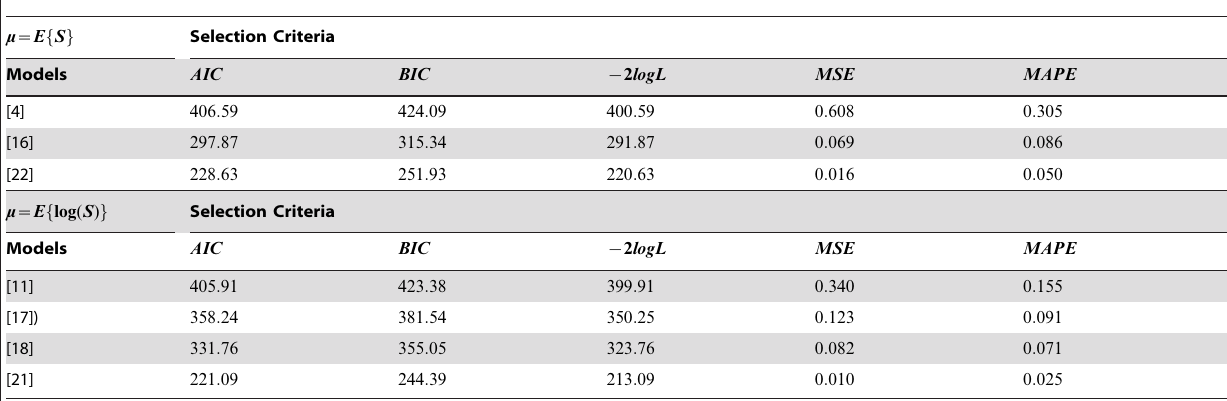
Table 1. Some of the traditional models adjusted with Gaussian errors.